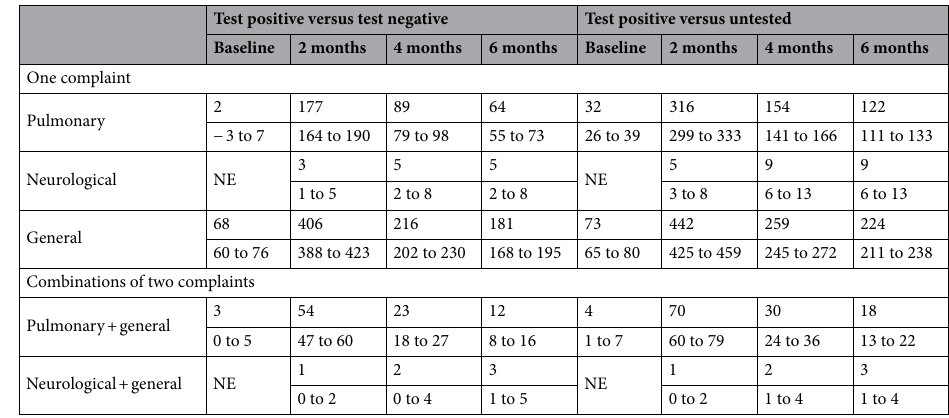
Table 2. The differences between the group testing positive and the comparison groups in prevalence of different long COVID complaints over time. Estimates are group differences in prevalence per 10 000 persons in the respective groups, with 95% confidence intervals, representing the group testing positive minus the group testing negative and the untested group, in separate analyses. Group differences for pulmonary + neurological and for all three combinations (pulmonary + neurological + general) could not be estimated (NE) due to too few observations for test